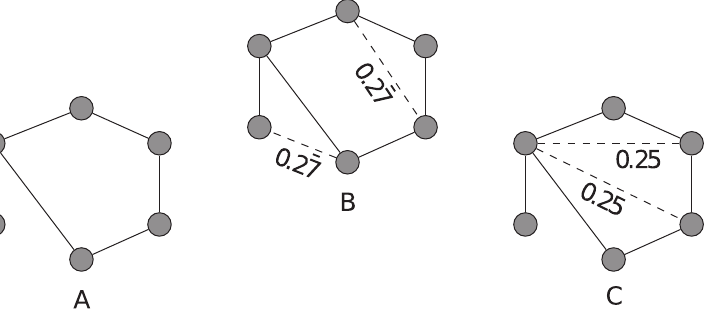
Fig 3. Example of non-optimal behaviour of the Greedy algorithm. (a) Original network with clustering coefficient C = 0. (b) Network with two links selected using the Greedy algorithm and clustering coefficient C ¼ 0 : �5 . (c) Optimal solution with clustering coefficient C ¼ 0 : 60�5 . The value corresponding to the dashed lines show the increase of clustering coefficient by adding the corresponding link to the network in (a). After adding one of the links depicted as dashed lines to the network in (c), the contribution of the other link increases to 0 : 3�5 , as the two nodes incident to that link now have one common neighbour more (see Eq 1).